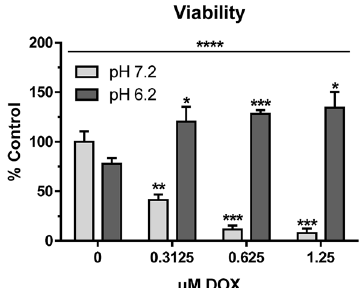
Figure 3. Acidic pH decreases MCF 7 increases doxorubicin drug resistance. Cell viability was examined by MTT assay after 72 h growth at indicated pH 6.2 or pH 7.2 in concentrations of doxorubicin as indicated. Data are shown as percent of control cells grown at pH 7.2 (mean + SEM, n = 4) with quadruple asterisks indicating p < 0.0001 by ANOVA, and single, double, and triple asterisks indicating p < 0.05, 0.01, and 0.001 by t-test compared to untreated controls, respectively as indicated.